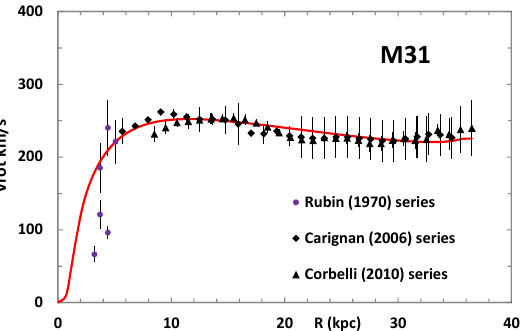
Figure 2. Rotational Curve (RC) for the massive galaxy M31, with rotational velocity for the LN model (solid line) and observations with error bars